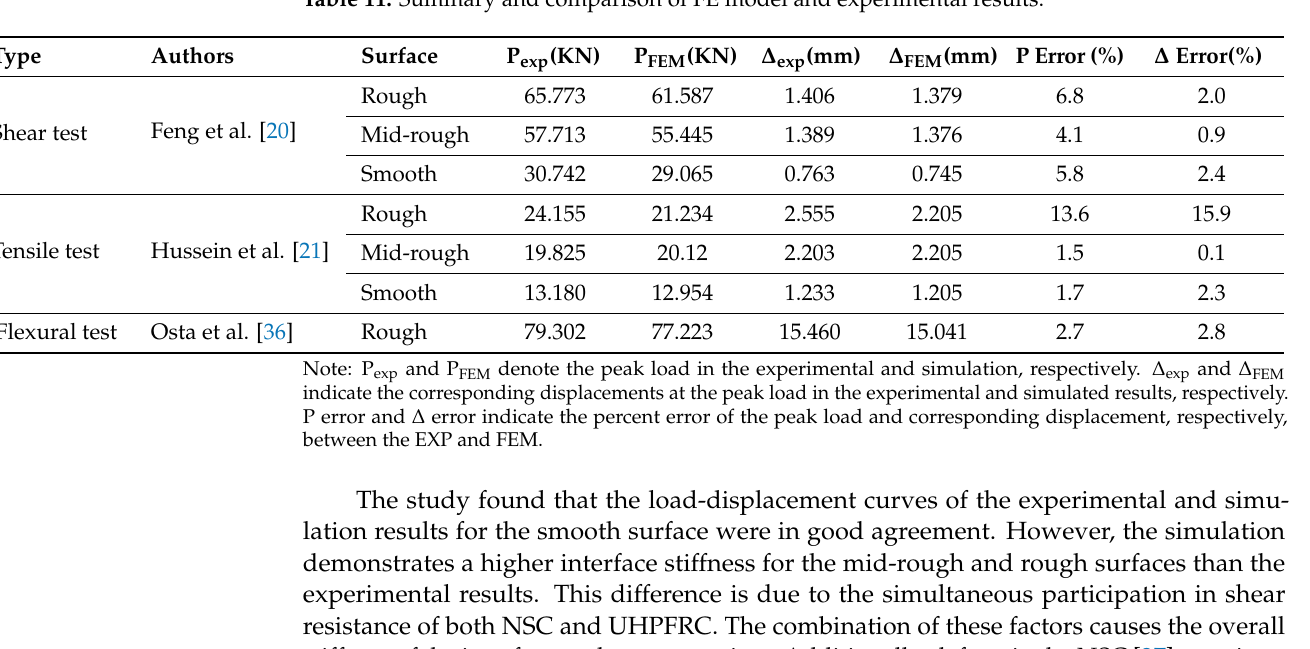
Table 11. Summary and comparison of FE model and experimental results .